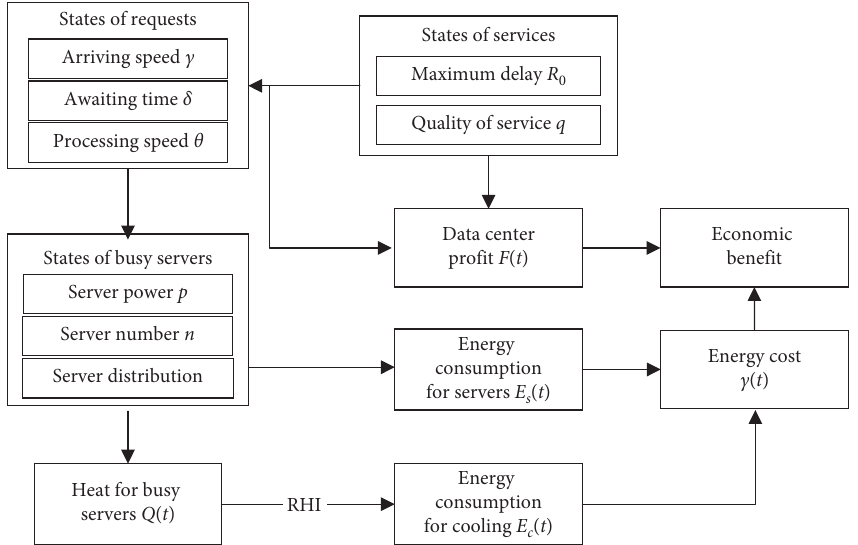
Figure 10: Relationships of benefits and relevant